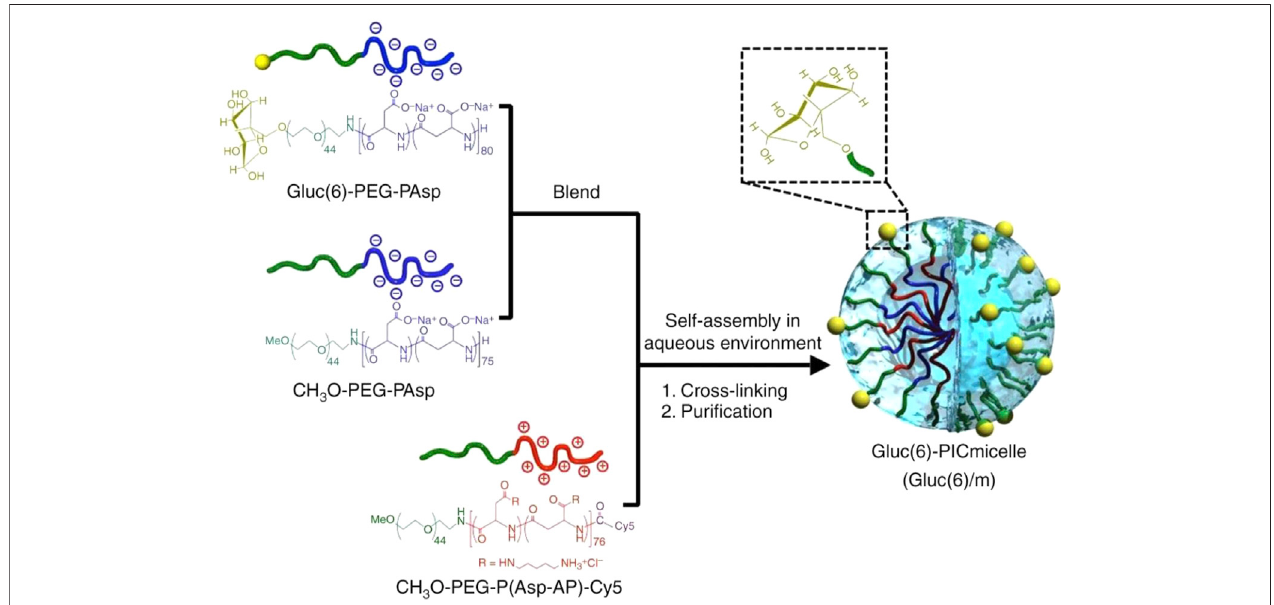
FIGURE6| AglucosylatednanocarrierusedtodeliverdrugsabletocrosstheBBBandreachthebraintissue.ReprintedwithpermissionfromAnrakuetal.(2017).